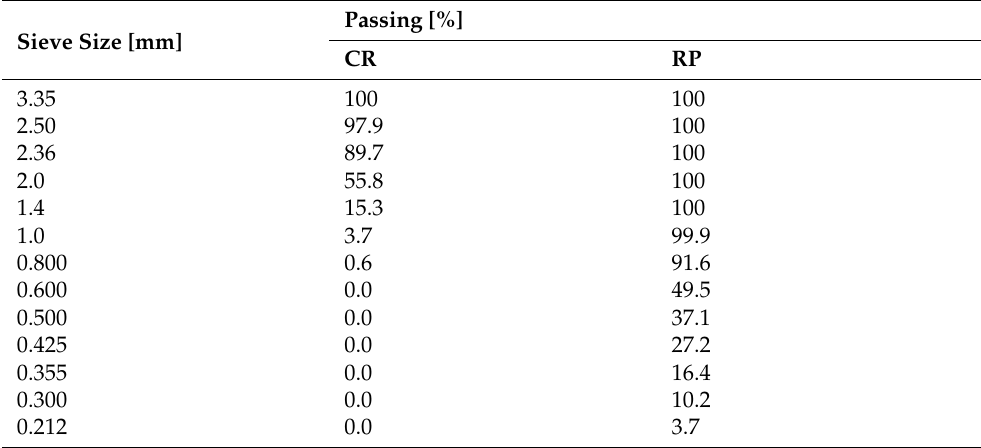
Table 3. Waste rubber properties.